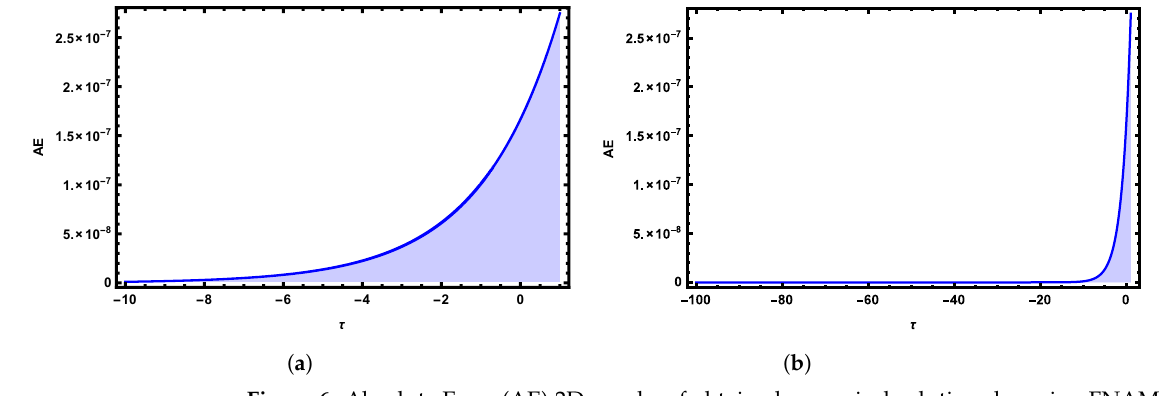
Figure 6. Absolute Error (AE) 2D graphs of obtained numerical solutions by using FNAM verses